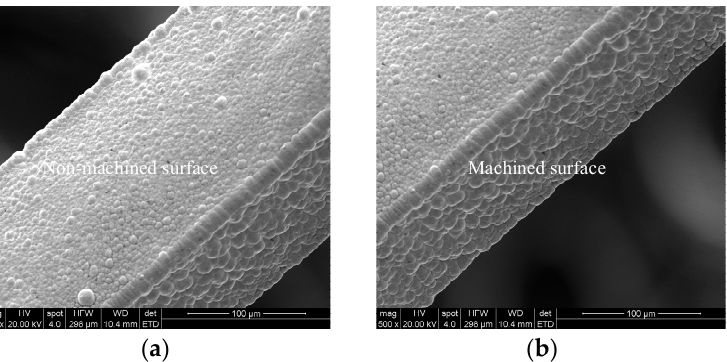
Figure 8. SEM examples after gold electroplating: ( a ) non-machined surface, ( b ) machined surface.